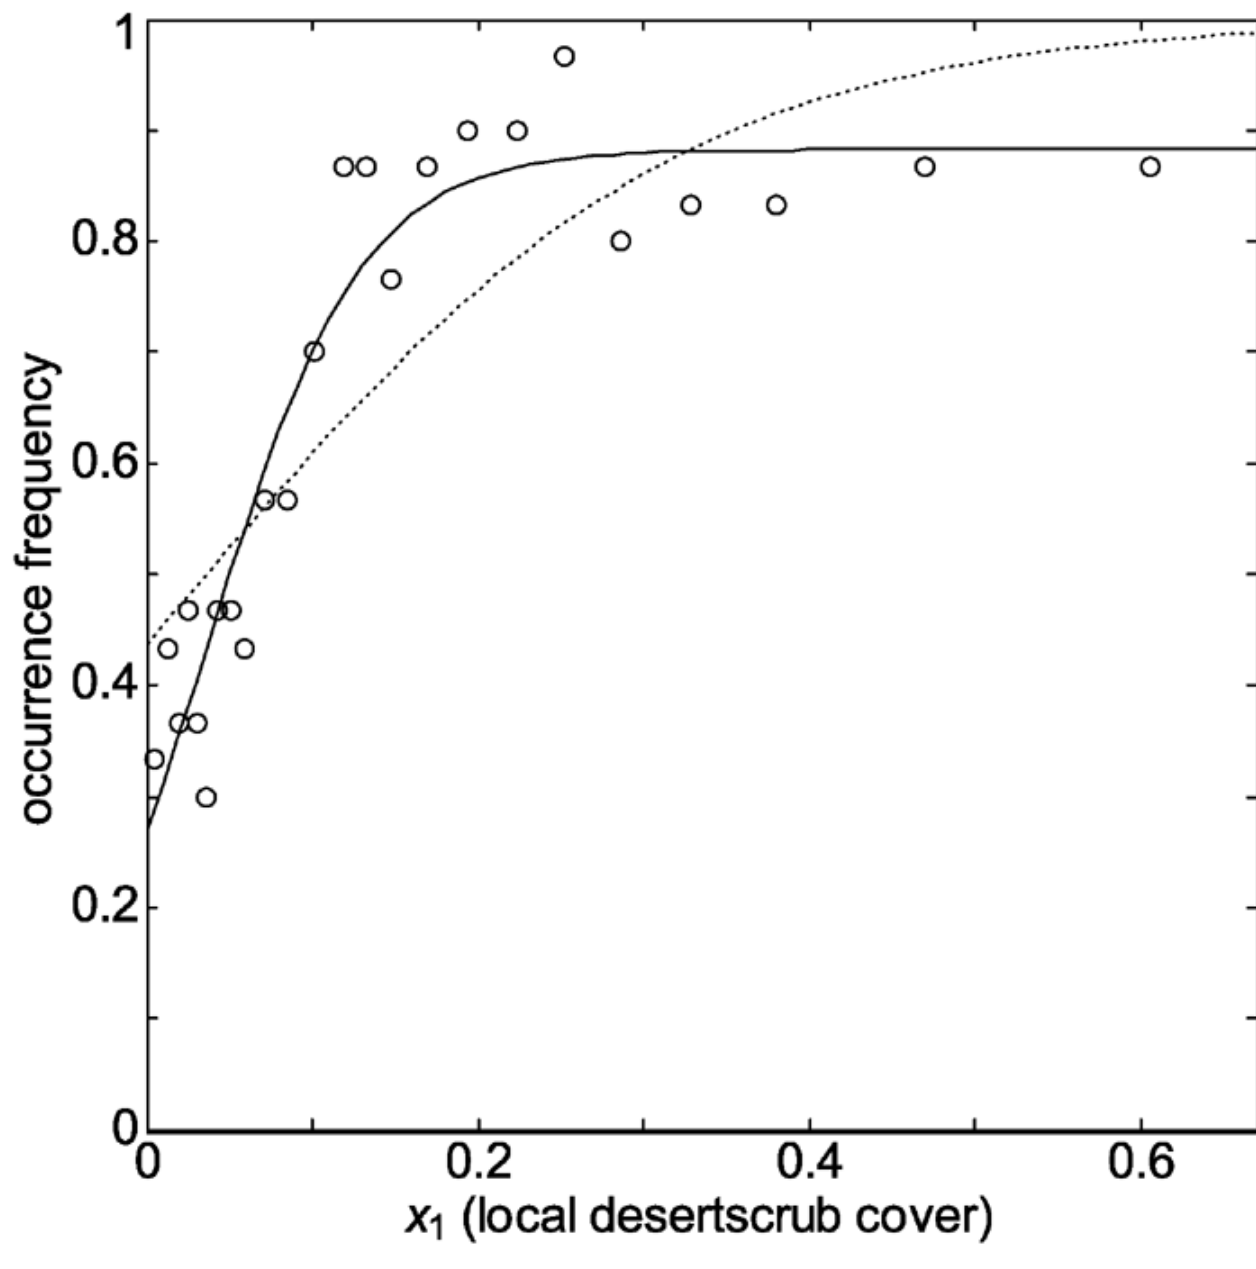
Fig. 3. Maximum likelihood fits of models M Tucson Bird Count data for Gambel’s Quail (GAQU) response to local desertscrub cover, i.e., proportion of desertscrub cover within 56 m. Open circles: average observed GAQU occurrence in bins of 30 sites having adjacent desertscrub cover